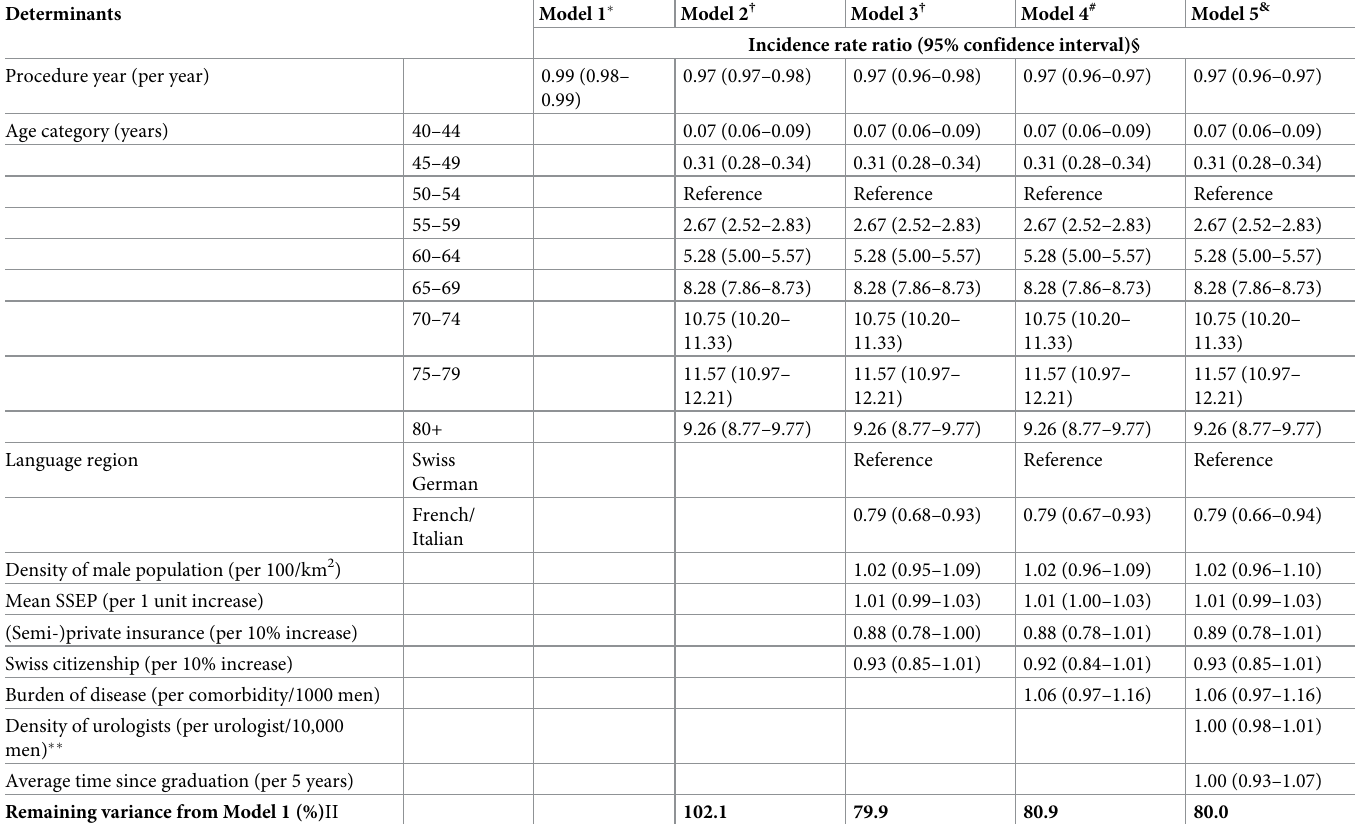
Table 3. Determinants of variance in the incidence rates of prostate surgery across 44 Swiss Hospital Service